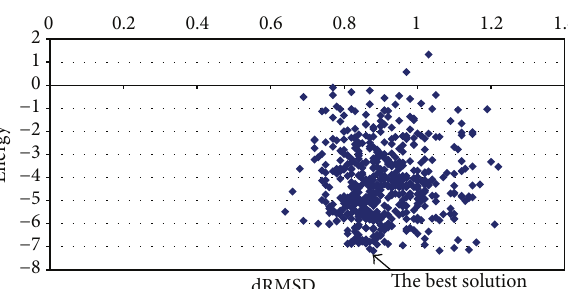
Figure 4: Chaotic function (10).